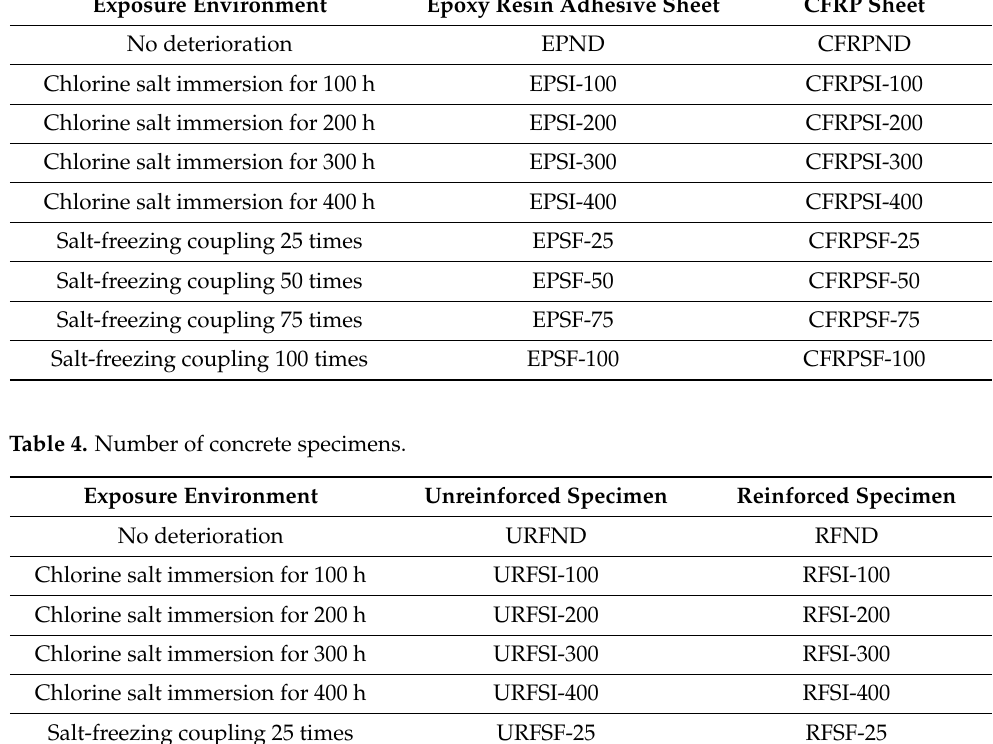
Table 3. Number of epoxy resin and CFRP sheet.